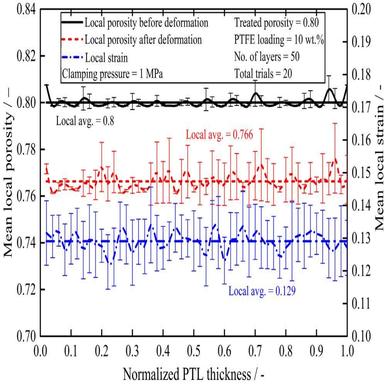
External compression effects on statistical-mean variation of local porosity and strain along the normalized PTLs thickness.